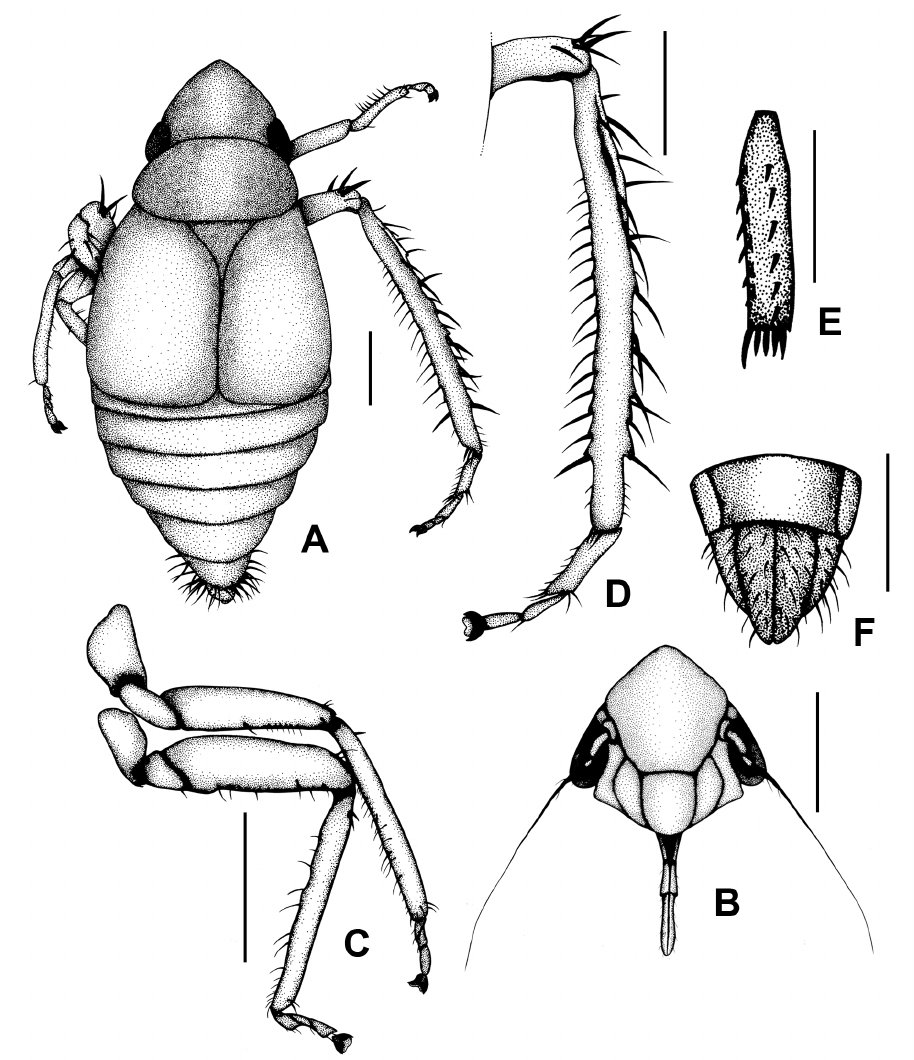
Fig. 3. Brevaphrodella nigra sp. nov. ♂. A . Body in dorsal view. B . Face. C . Pro- and mesothoracic legs in ventral view. D-E . Metathoracic leg. D . Apical portion of femur, tibia, and tarsomeres, dorsolateral view. E . First tarsomere, ventral view. F . Subgenital plates, and valve, ventral view. Scale bars: A-D, F = 0.5 mm; E = 0.25